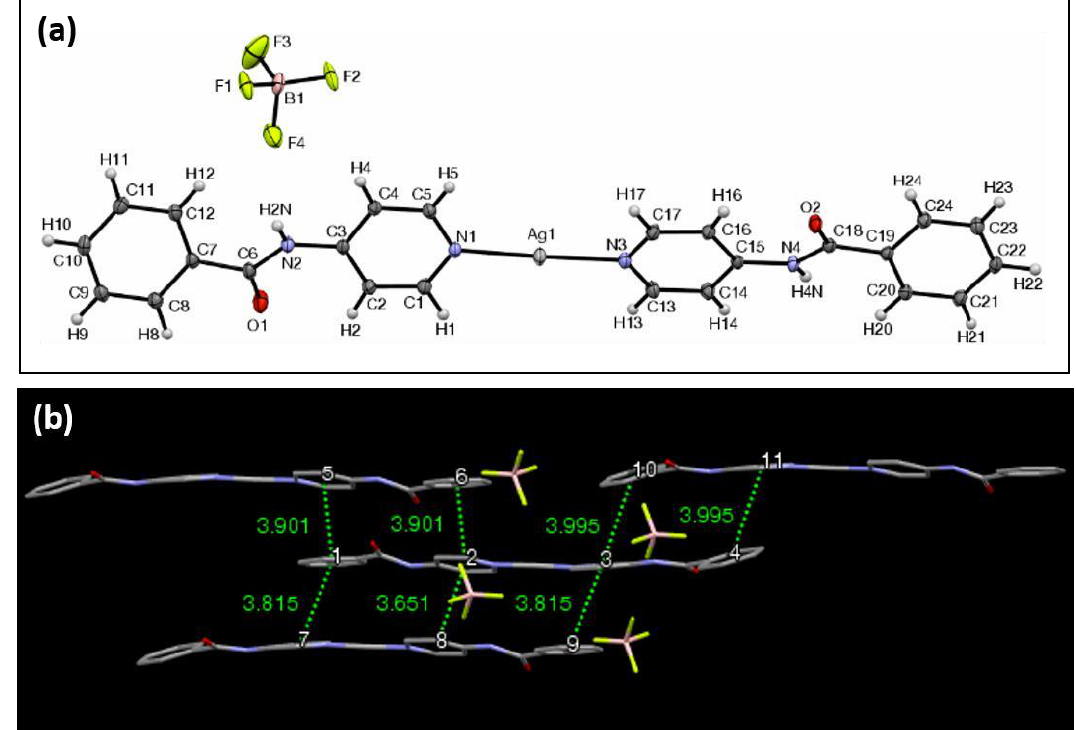
Figure 6. ( a ) The ORTEP view of complex 5 , with ellipsoids drawn at 30% probability. ( b ) The view of the π–π interaction network of complex 5 , highlighting the centroid-centroid distances of less than 4.00 Å .